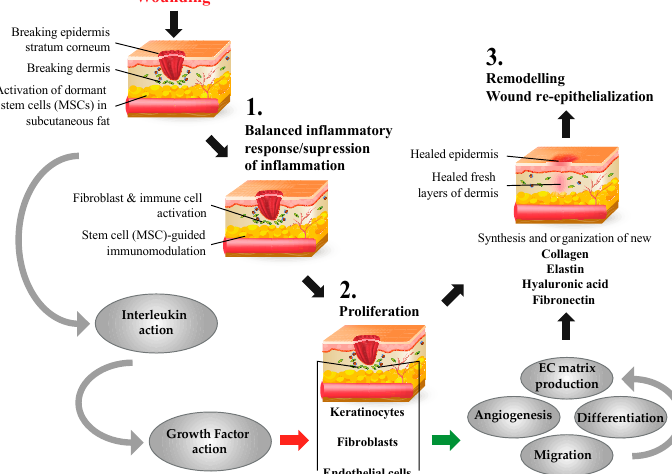
Figure 3. Stages of Wound Healing: Wound healing is a 3-step process. (1) Inflammation stage initiated by migration of inflammatory and stem cells to the wound-site; (2) Proliferation and Granularization stage involving secretion of growth factors and migration of fibroblasts, keratinocytes and endothelial cells to initiate ECM production and repair and; (3) Re-epithelialization stage is the final stage of wound healing process marked by the synthesis and organization of new collagen and elastin fibers resulting in healed epidermis.